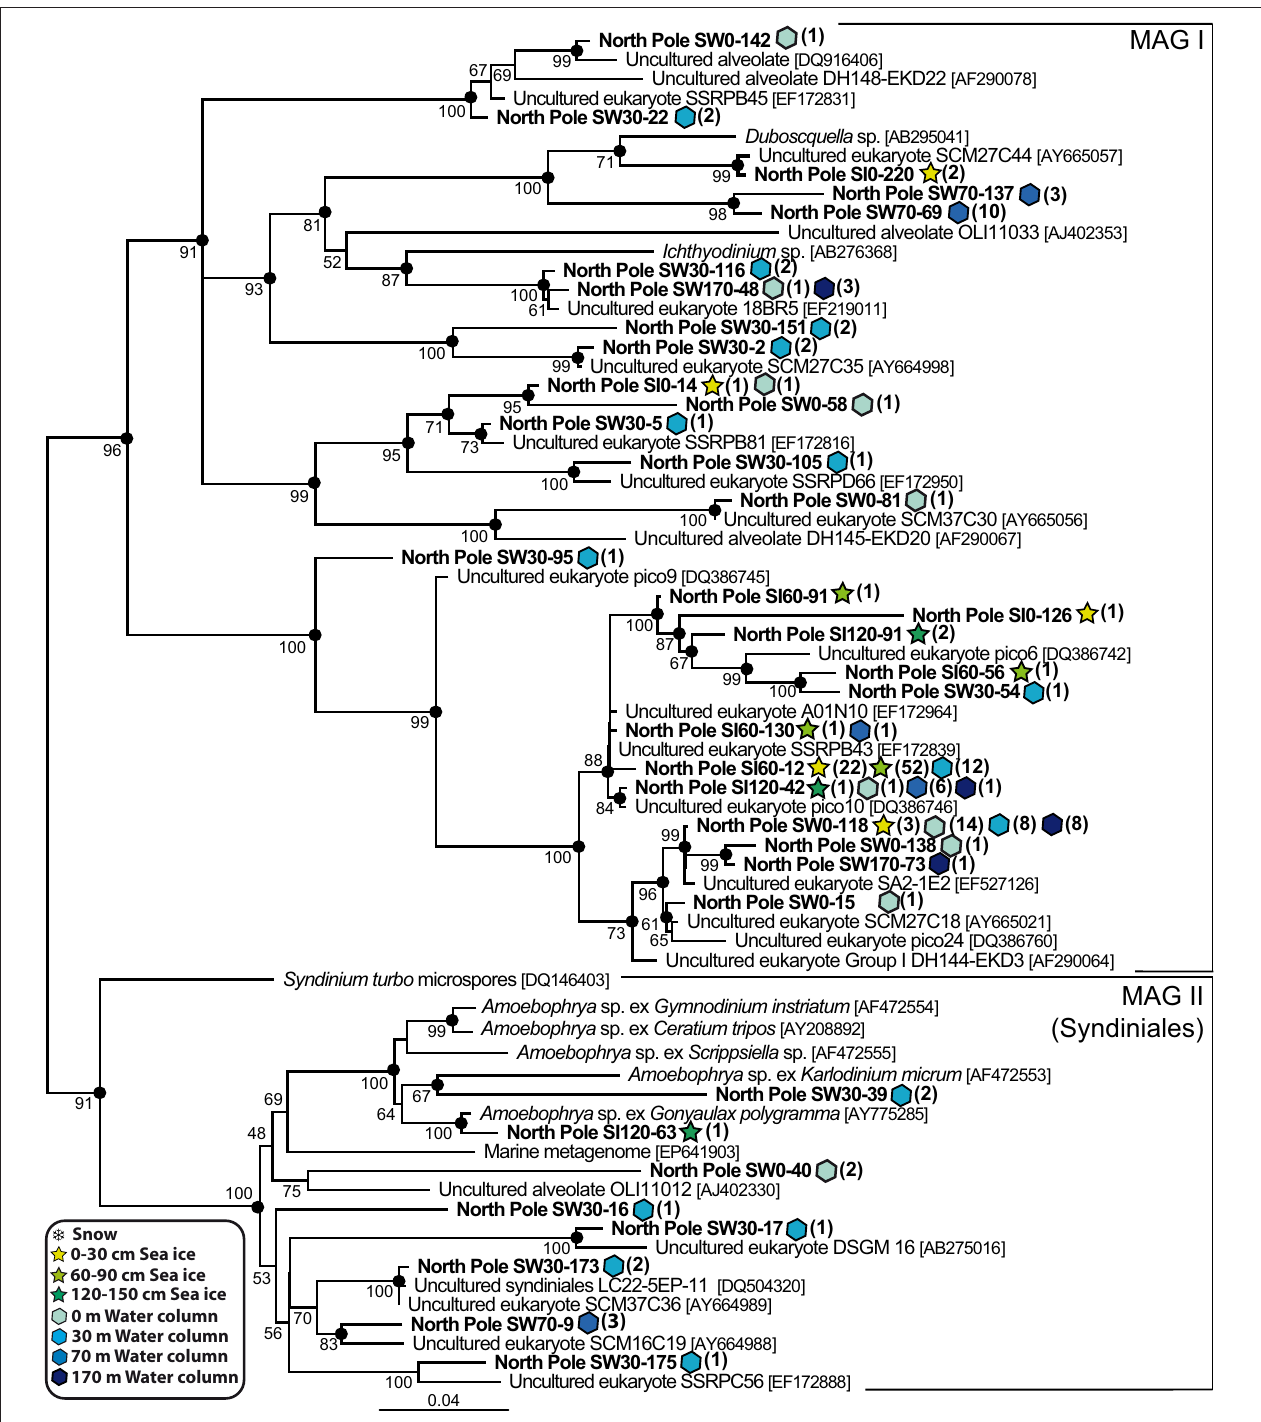
Figure 5 | Maximum likelihood phylogenetic tree of Marine Alveolate group i and ii (Syndiniales) phylotypes. The tree was rooted with perkinsozoan sequences